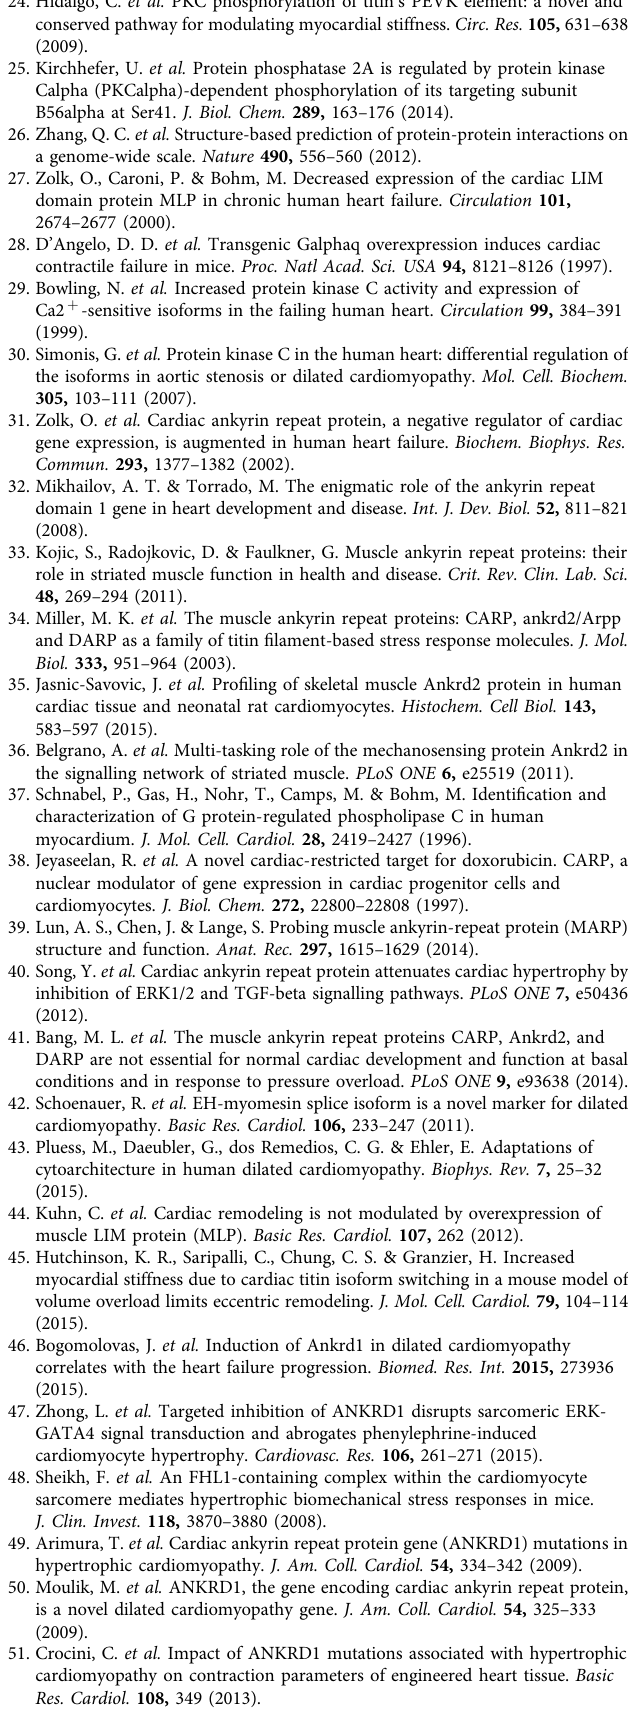
Figs 1e and 2g are mean values ± s.e. Significance was evaluated by the two-tailed student’s t -test. Sample size ( n -values) and P values are indicated in the figures and/or figure